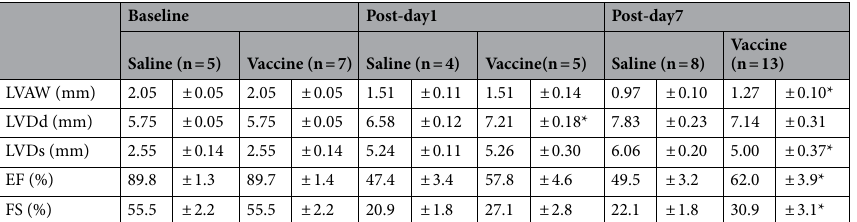
Table 1. Cardiac ultrasonography was carried out before MI induction (on the day of surgery) and after MI induction (1 day and 7 days later). Data shows no difference between the saline and vaccine groups at baseline and on post-day1. However, vaccination prevents the deterioration of cardiac function and myocardial remodeling on post-day7. MI myocardial infarction, LVAW left ventricular anterior wall, LVDd diastolic dimension of left ventricle, LVDs systolic dimension of left ventricle, EF ratio of left ventricular ejection fraction, FS ratio of left ventricular fractional shortening. * P < 0.05. Values were compared between the saline group and the vaccine group by Student’s t